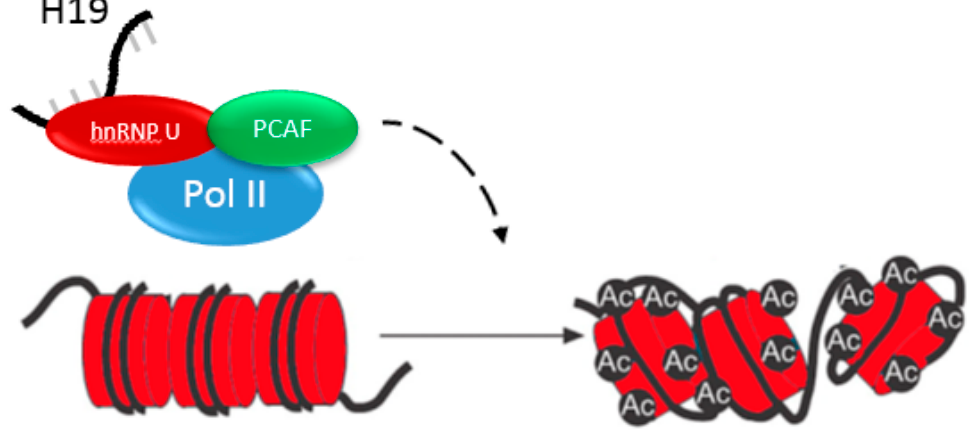
Figure 3. H19 can also activate gene transcription. H19 binds hnRNP U, which is a member of the complex with RNA Polymerase II and PCAF, a histone acetyltransferase. H19 binding results in the upregulation of the miR-200 family of microRNAs through histone H3 acetylation.